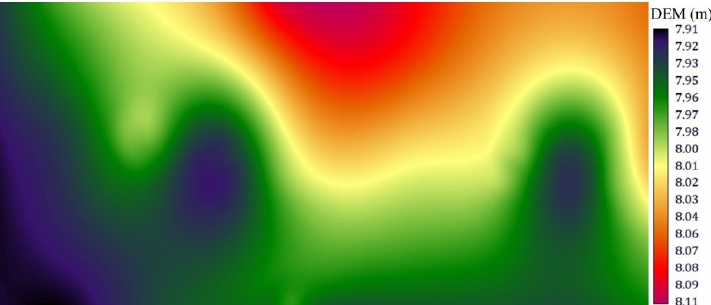
Figure 7. Digital elevation model (DEM) representing the microtopography of the study site. Visual interpretation can be used to identify some characteristics of the terrain features that exhibit some similarity with the thermal information.